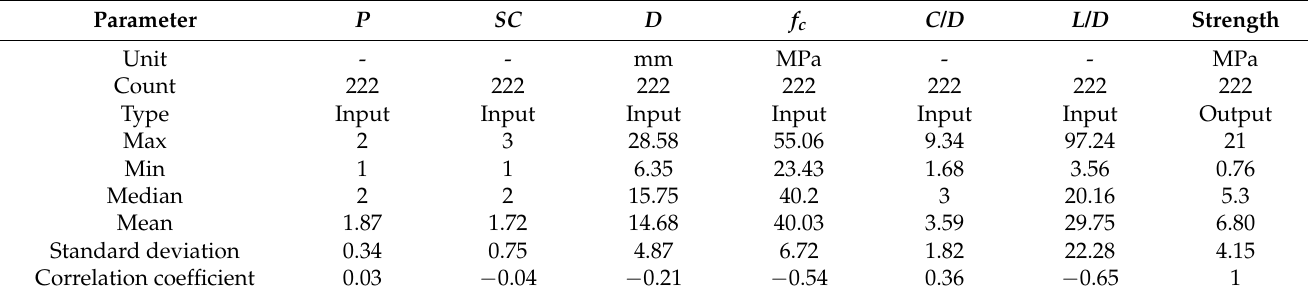
Figure 2. Histograms and normal distribution of input and output variables. Table 1. Statistics of the parameters for the input and output.